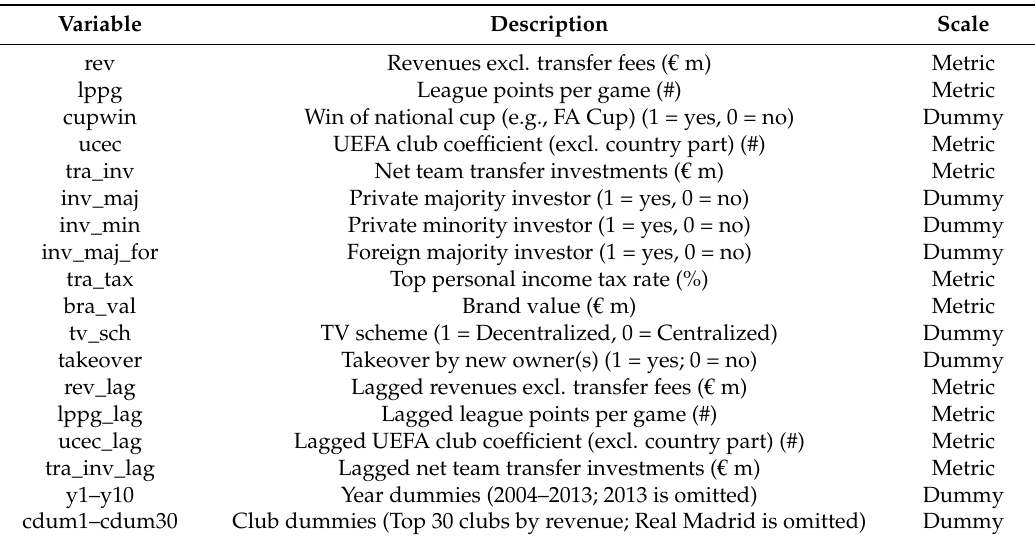
Table 5. Overview of key